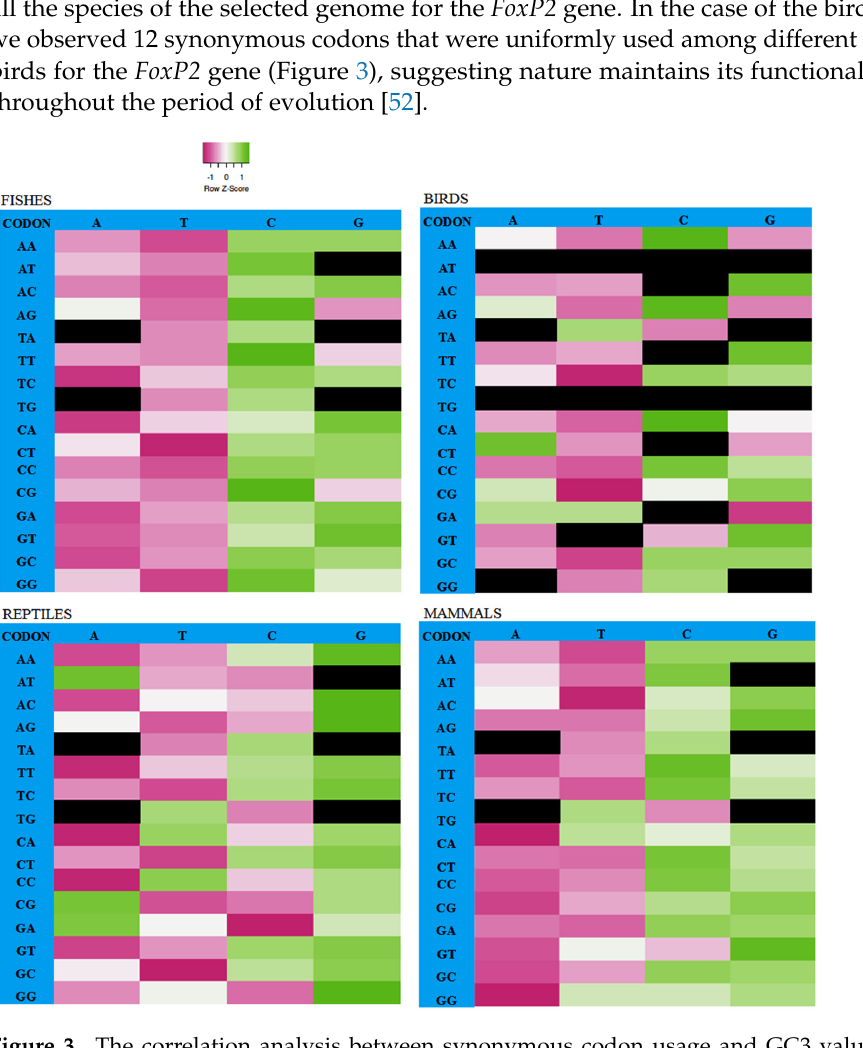
Figure 3. The correlation analysis between synonymous codon usage and GC3 values using a heatmap. The black fields represent stop codons (TAA, TAG, and TGA) and non-degenerate codons (ATG, TGG). Uniform usage codons (ATA, ATT, ATC, ACC, TTC, TGT, TGC, CTC, GAC, GTT, GGA, and GGG) were observed only among bird species and are represented as black